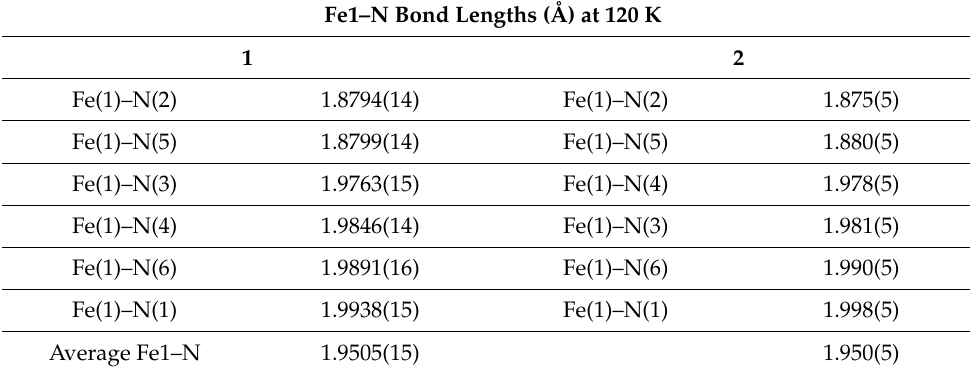
Table 4. Coordination bond lengths for 1 and 2 at 120